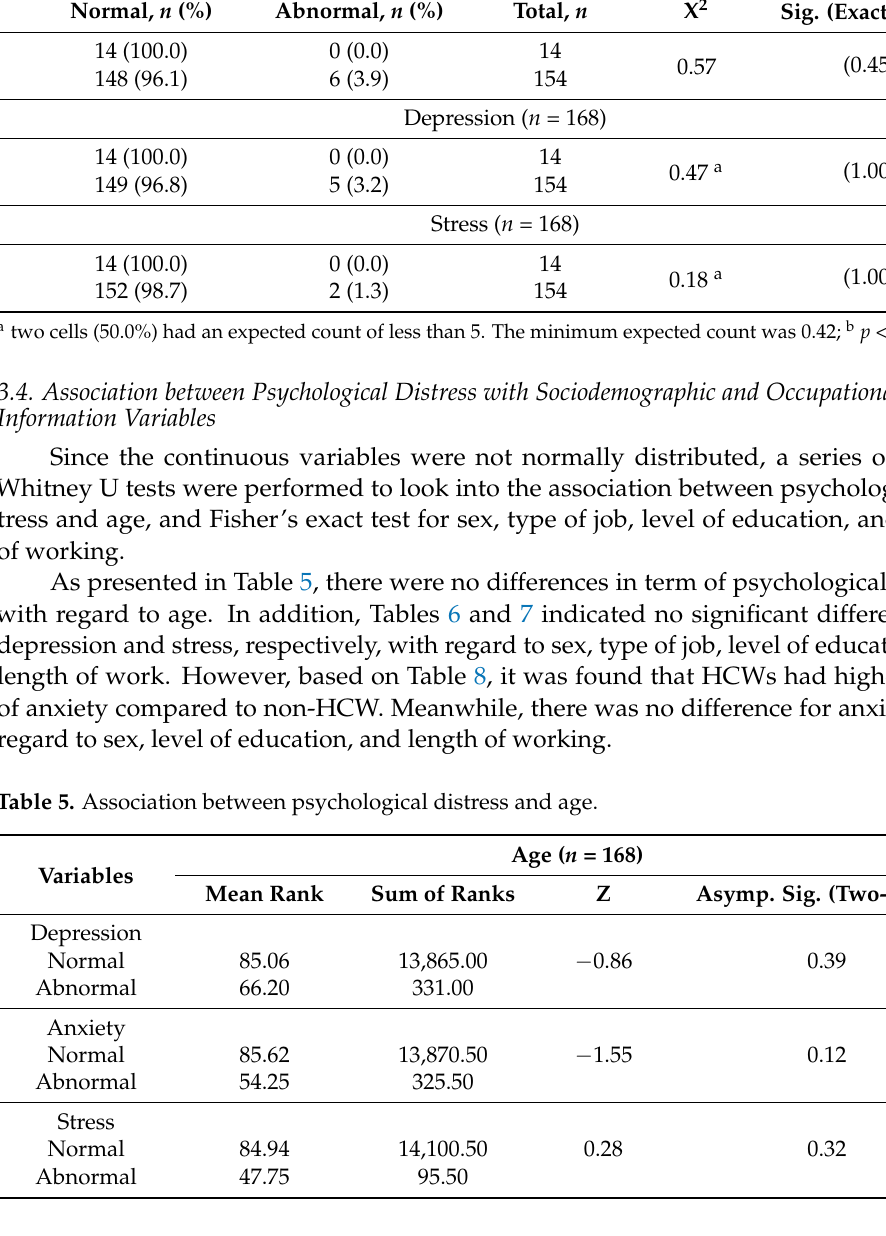
Table 6. Association between depression and sociodemographic and occupational information